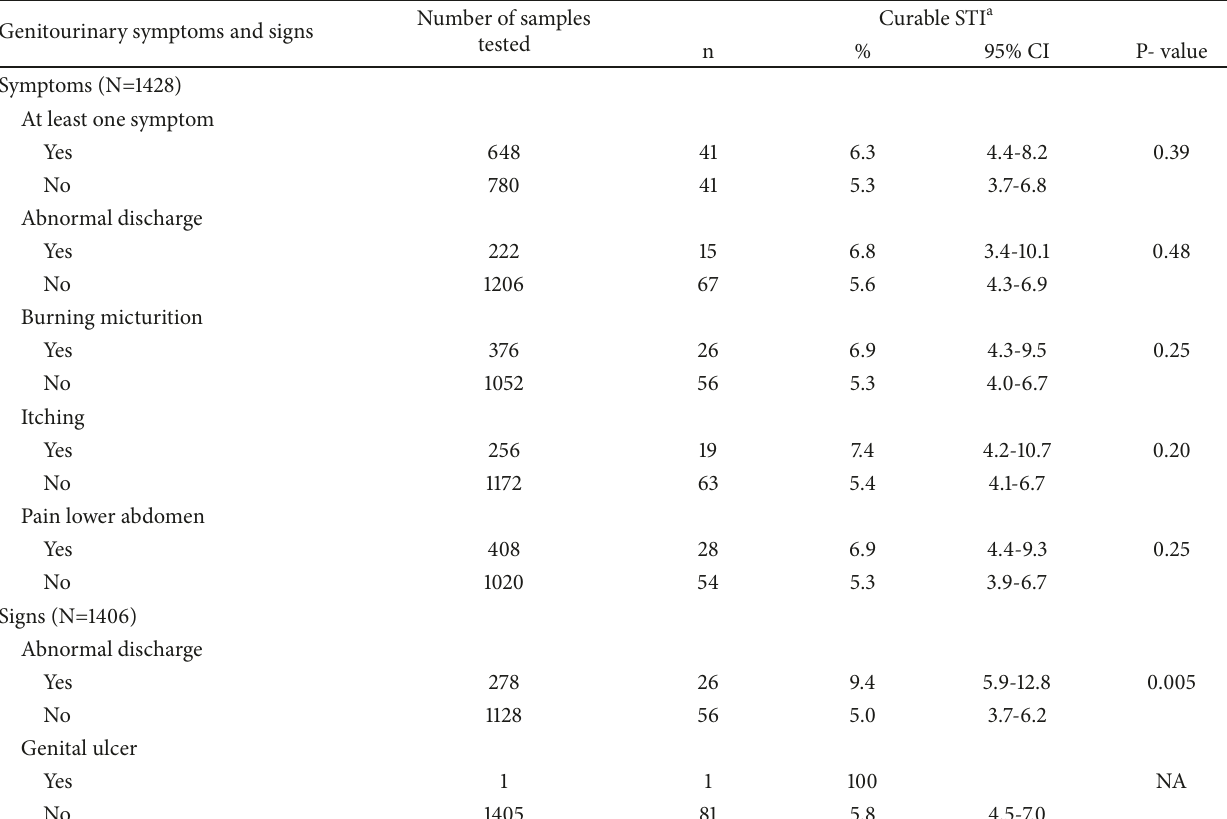
Table 3: Genitourinary symptoms and clinical finding on speculum examination in relation to presence of curable sexually transmitted infections (STIs) in a population-based study among women from rural